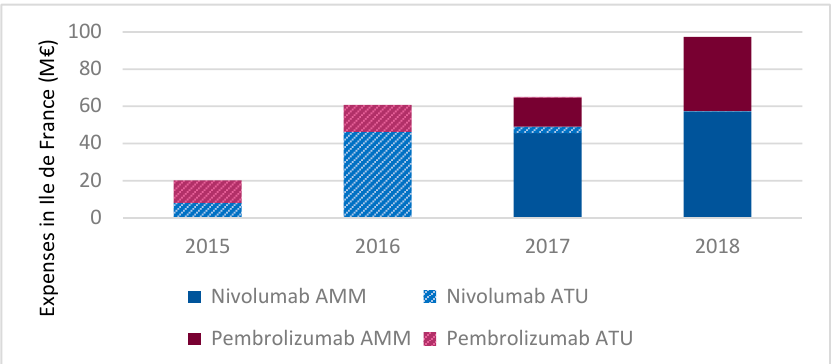
Figure 1. Evolution of the amount of anti-PD-1 spending in public and private healthcare facilities in Ile-de-France from January 2015 to December 2018 (data processed after extraction from the ScanSanté platform that allows users to make queries in order to obtain formatted results, processed by ATIH).